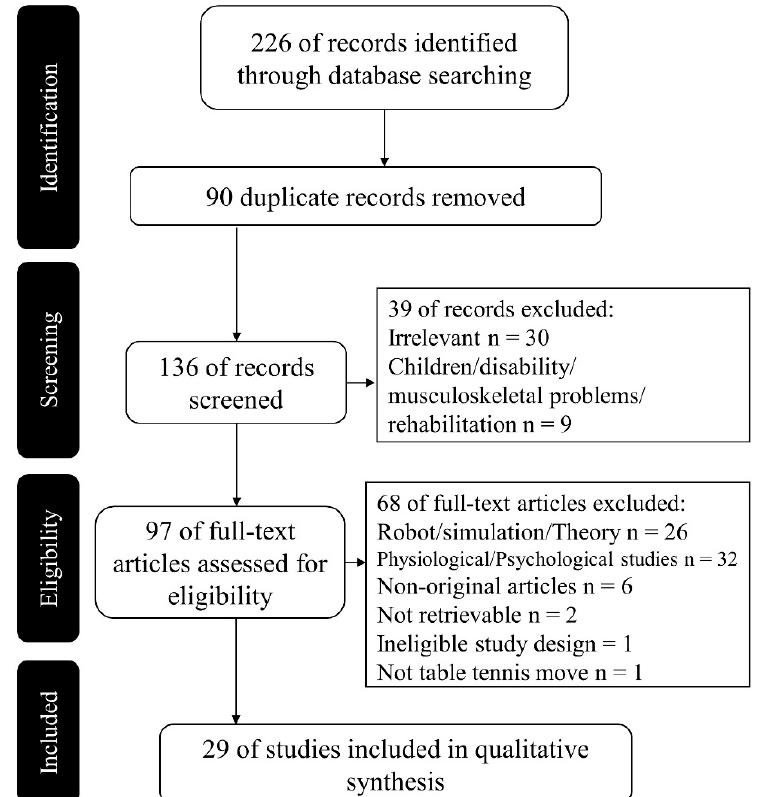
Figure 1. Flowchart of the systematic search and selection process.